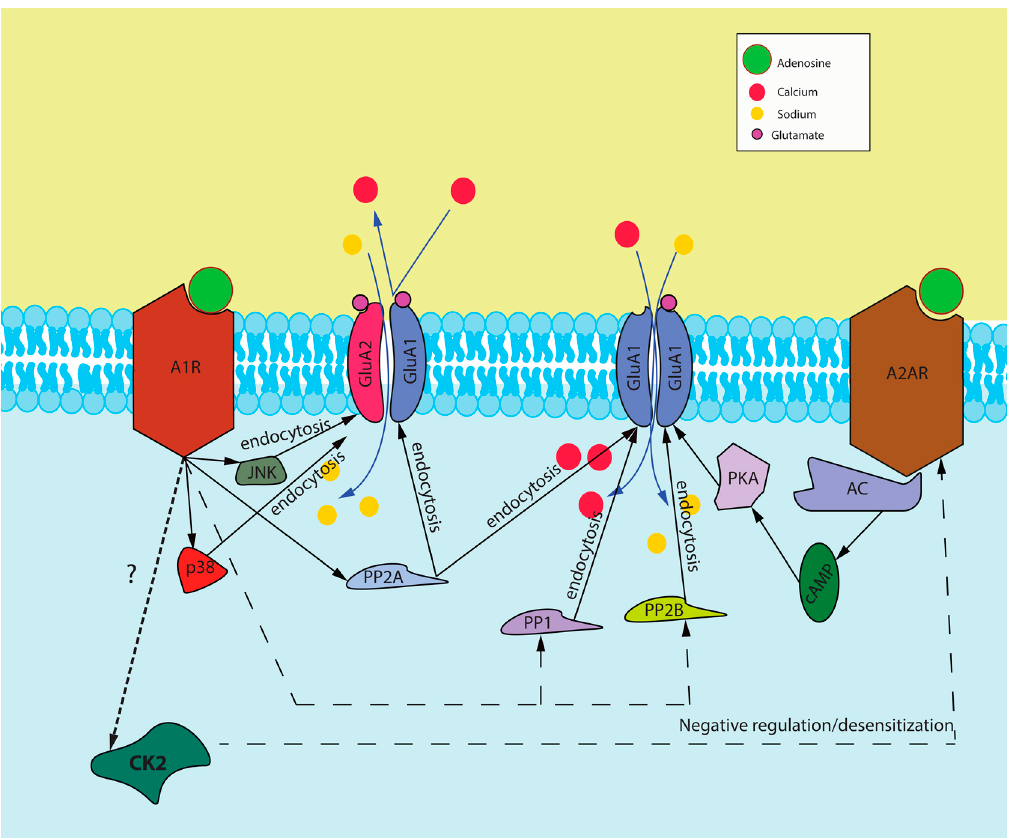
Figure 2. Proposed signaling cascade induced by A1R and A2AR activation. This figure represents our proposed interaction between A1Rs and A2ARs and how they interact to modulate the surface expression of AMPA receptors and also our proposed mechanism of cross-talk through CK2